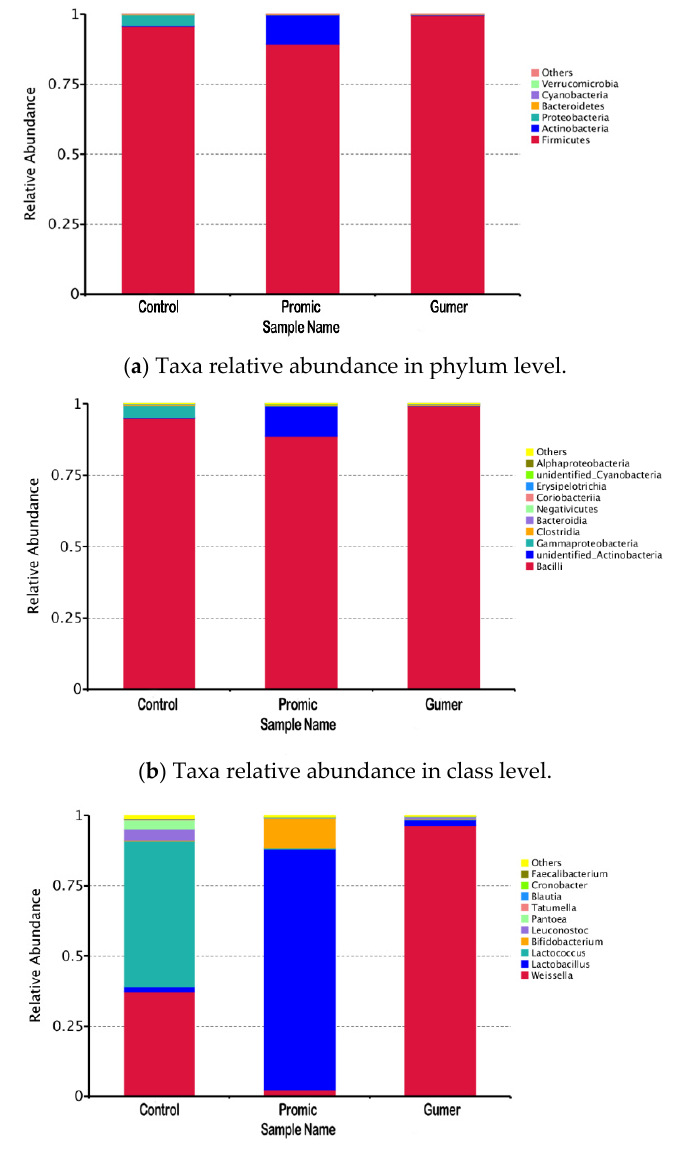
Figure 1. Relative abundance of taxa in PP fermentation.